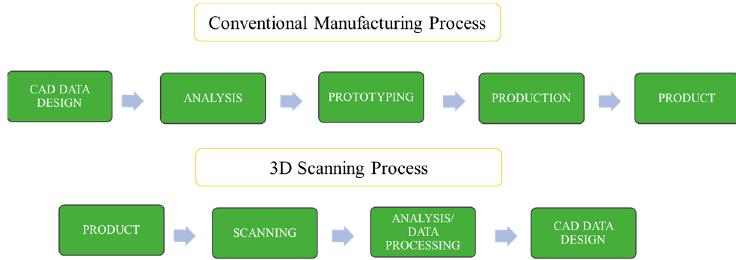
Figure 13. Conventional Vs 3D scanning process.